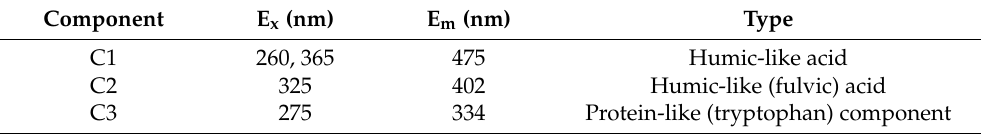
Table 2. Descriptions of the three fluorescence components identified by PARAFAC